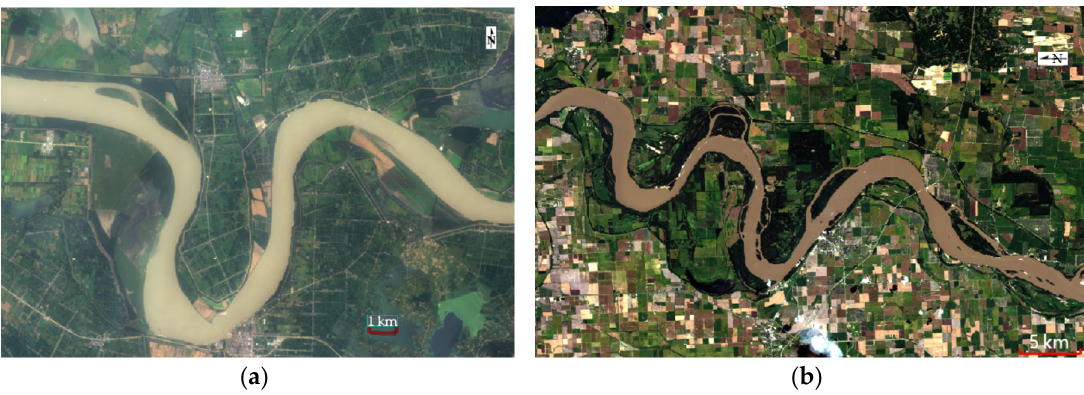
Figure 1. Continuous bends in nature. ( a ) The Jingjiang Reach, Yangtze River, China. ( b ) The Mississippi River.